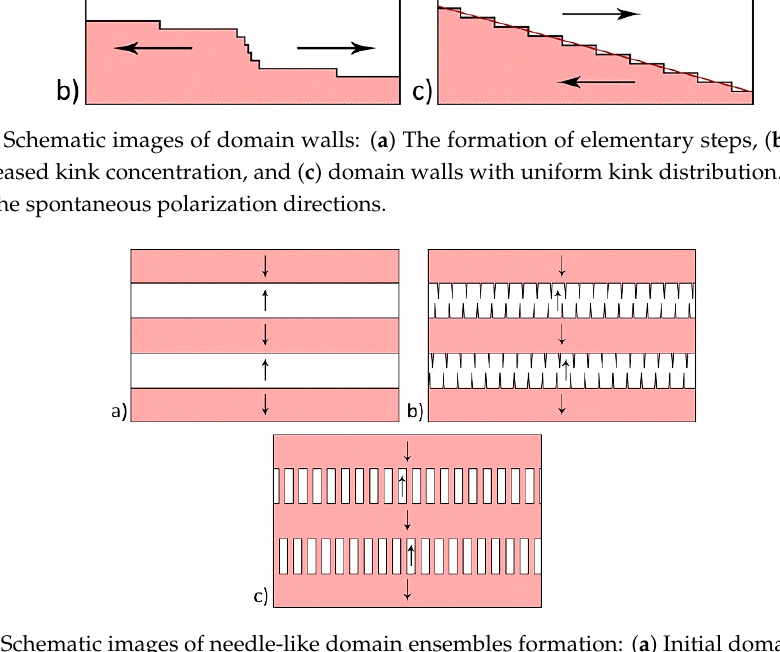
Figure 4. Schematic images of needle-like domain ensembles formation: ( a ) Initial domain structure, ( b ) polarization switching in one direction, and ( c ) merging of the projecting parts of charged domain walls. The arrows indicate the spontaneous polarization directions.